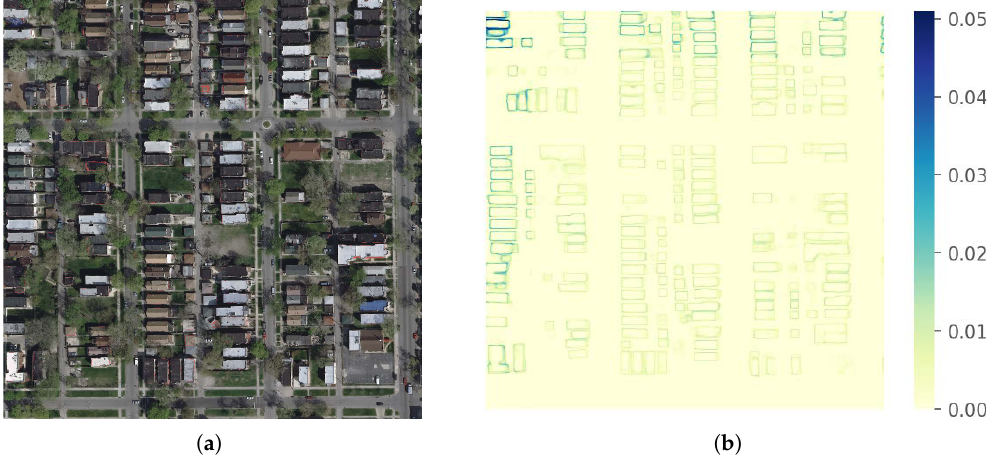
Figure 12. The impacts of the binary geohash can be better recognized by a heat map of the buildings’ prediction score. The buildings’ prediction scores are the output of the softmax layer within the range [ 0,1 ] . The heat map is obtained by visualizing the absolute values of the difference between the prediction scores of the geohash codes and the zeroed codes. The sample images have a size of 1024 ×